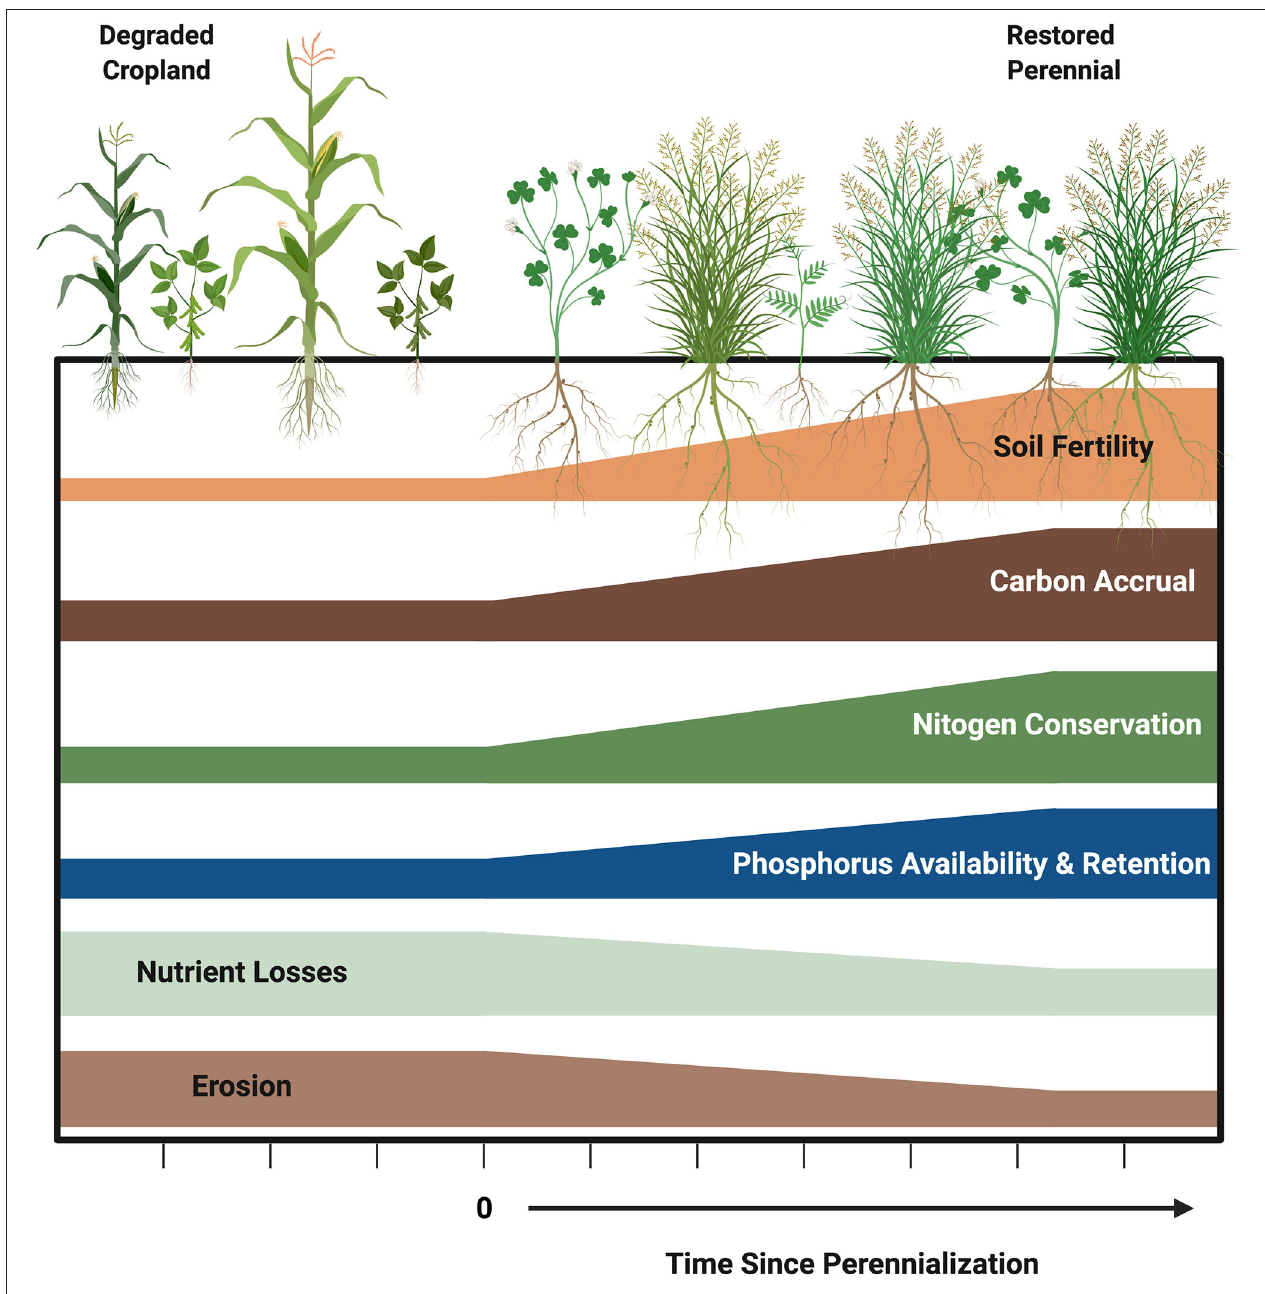
FIGURE 1 | Patterns of key agronomic and biogeochemical process changes during the restoration of soil fertility via perennialization of degraded